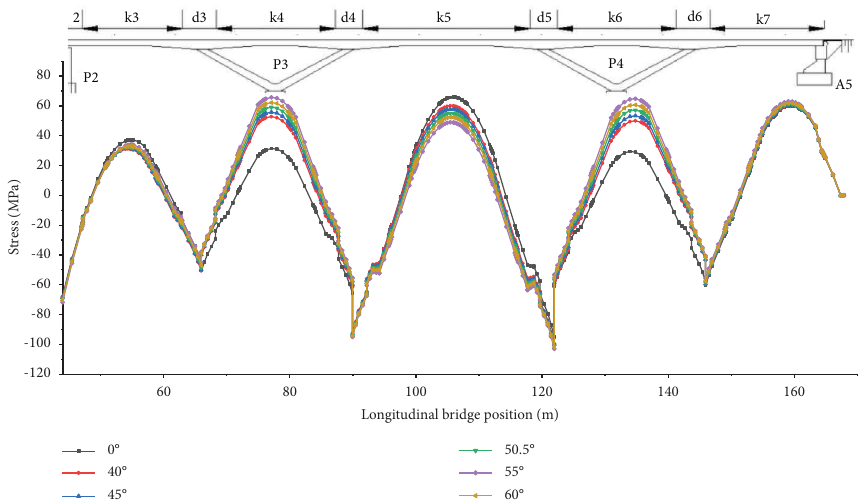
Figure 13: Comparison of stresses in the lower fange of a steel main beam.